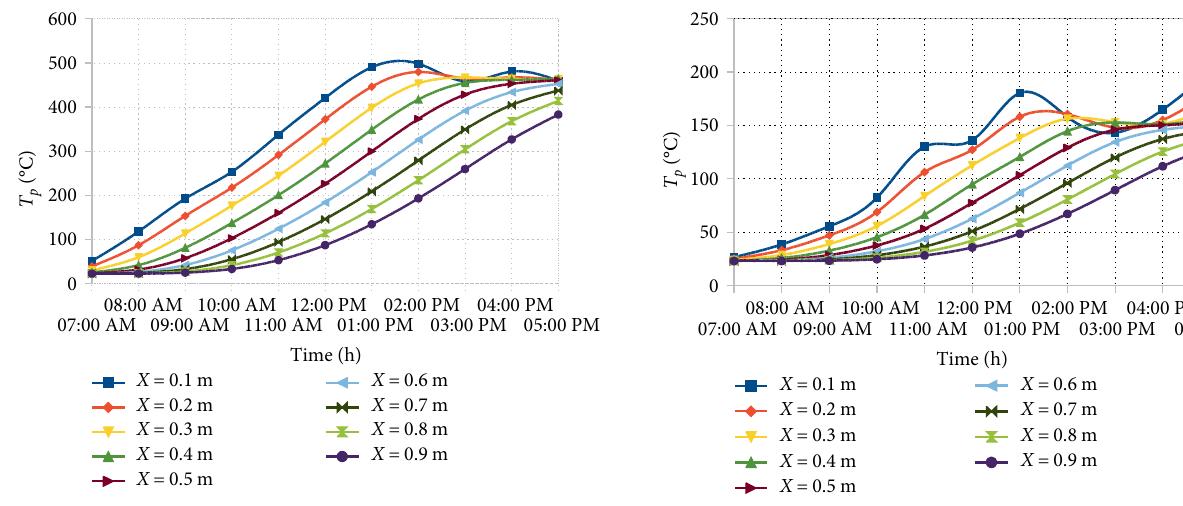
Figure 13: Temperature of thermocline storage versus charging time from 7AM to 5 PM for the lowest DNI in July.